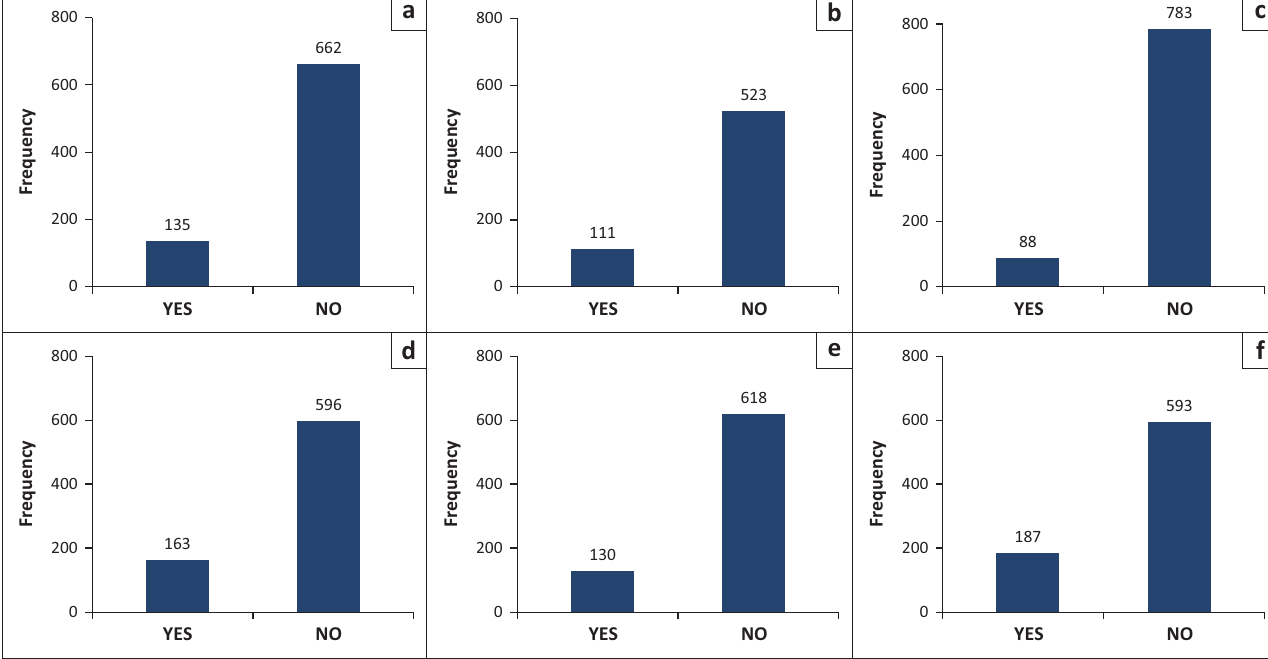
FIGURE 2: Households access to credit by zones in Nigeria: (a) north-central; (b) north-east; (c) north-west; (d) south-east; (e) south-south; (f) south-west.